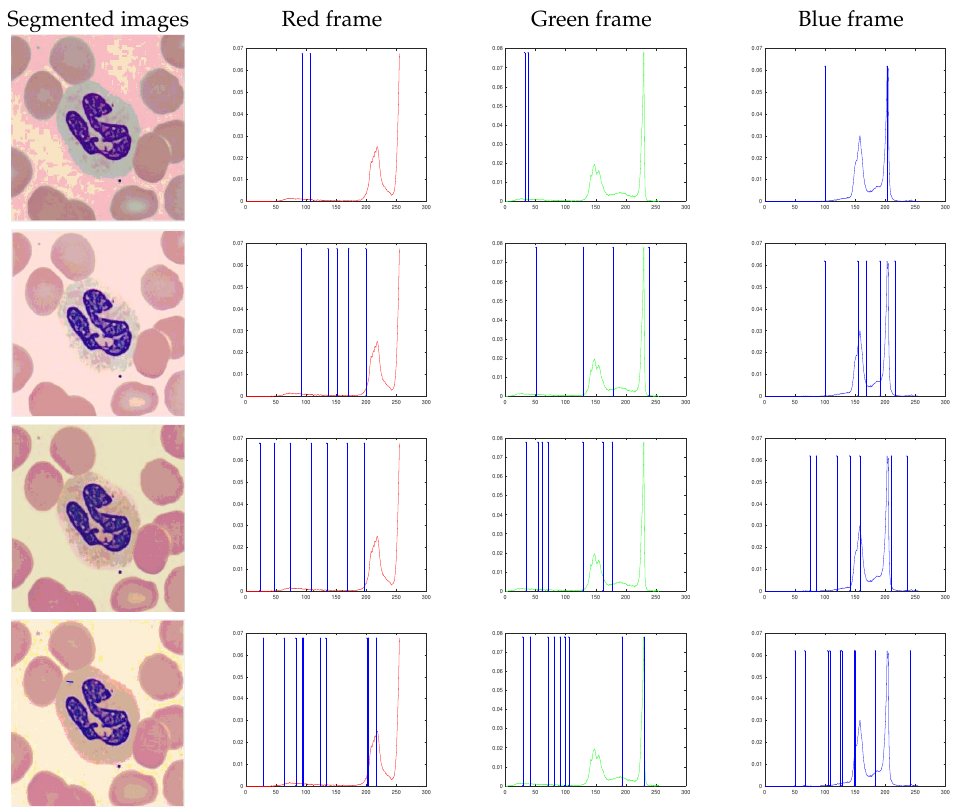
Figure 8. Threshold outcomes of each layer of a color image using the mSAR algorithm with the fuzzy entropy